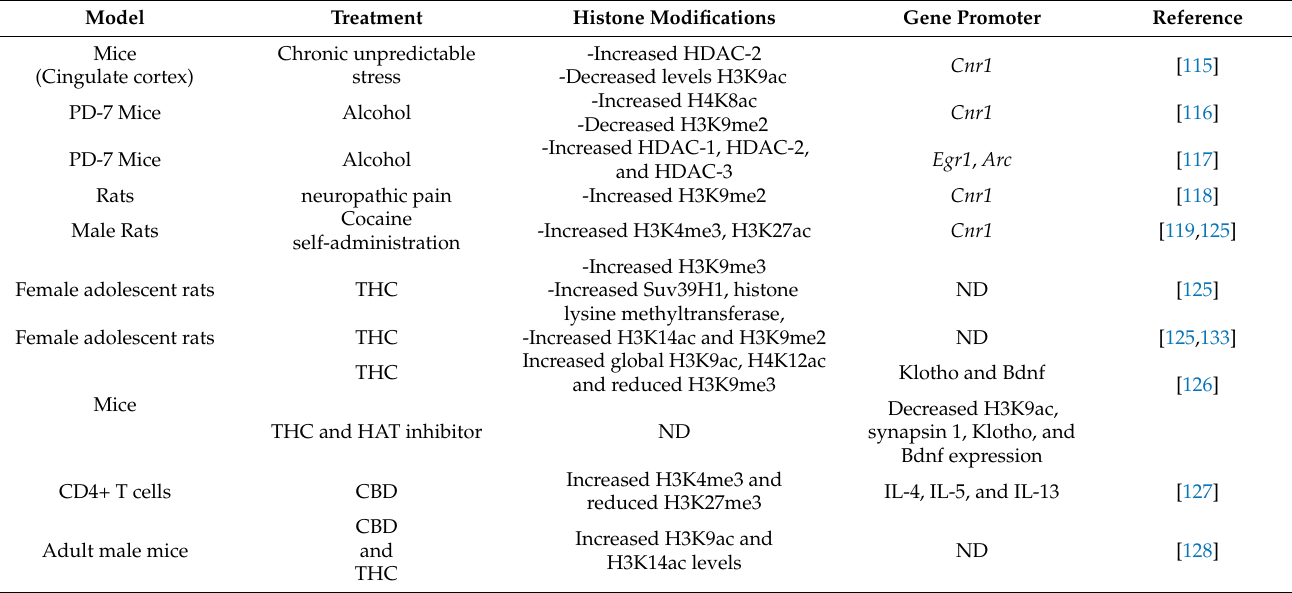
Table 2. Histone modifications at the CB 1 receptor gene